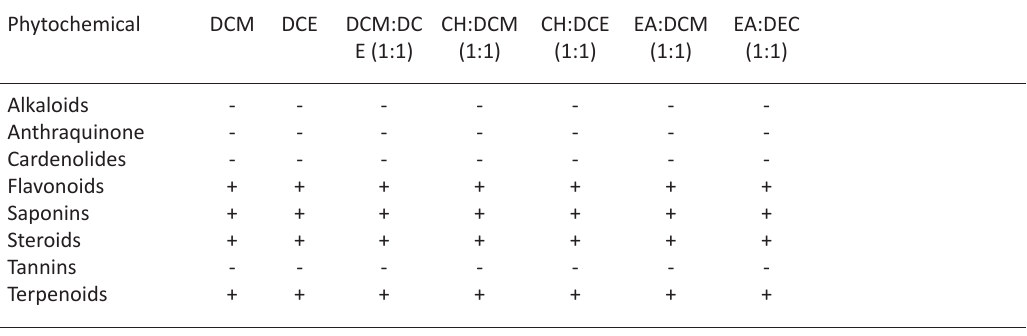
Table 2. Phytochemical assessment data of the extracts of O. europaea leaves